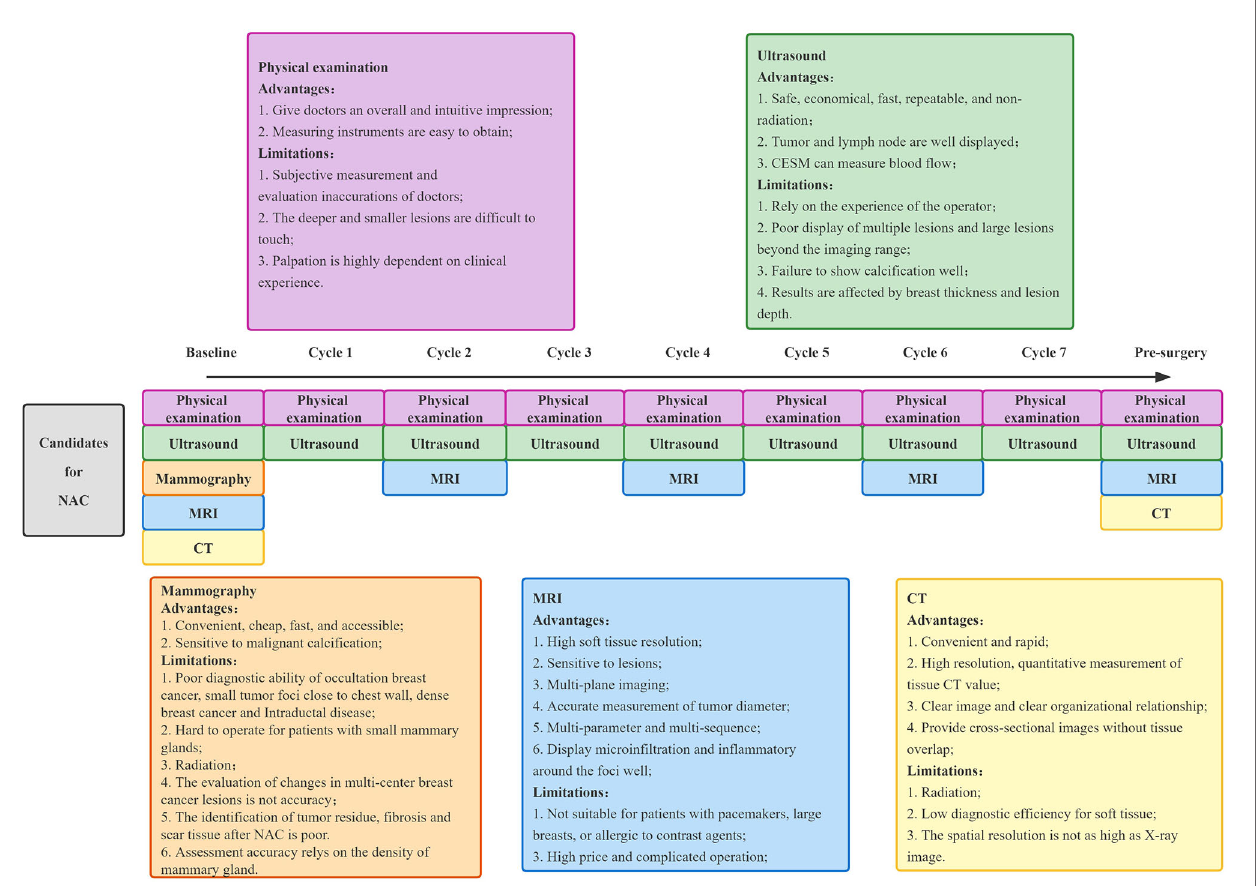
FIGURE 2 | The model of imaging technology to assess the ef fi cacy of NAC for breast cancer in Yunnan Cancer Hospital. NAC, neoadjuvant chemotherapy; MRI, magnetic resonance imaging; CT, computed